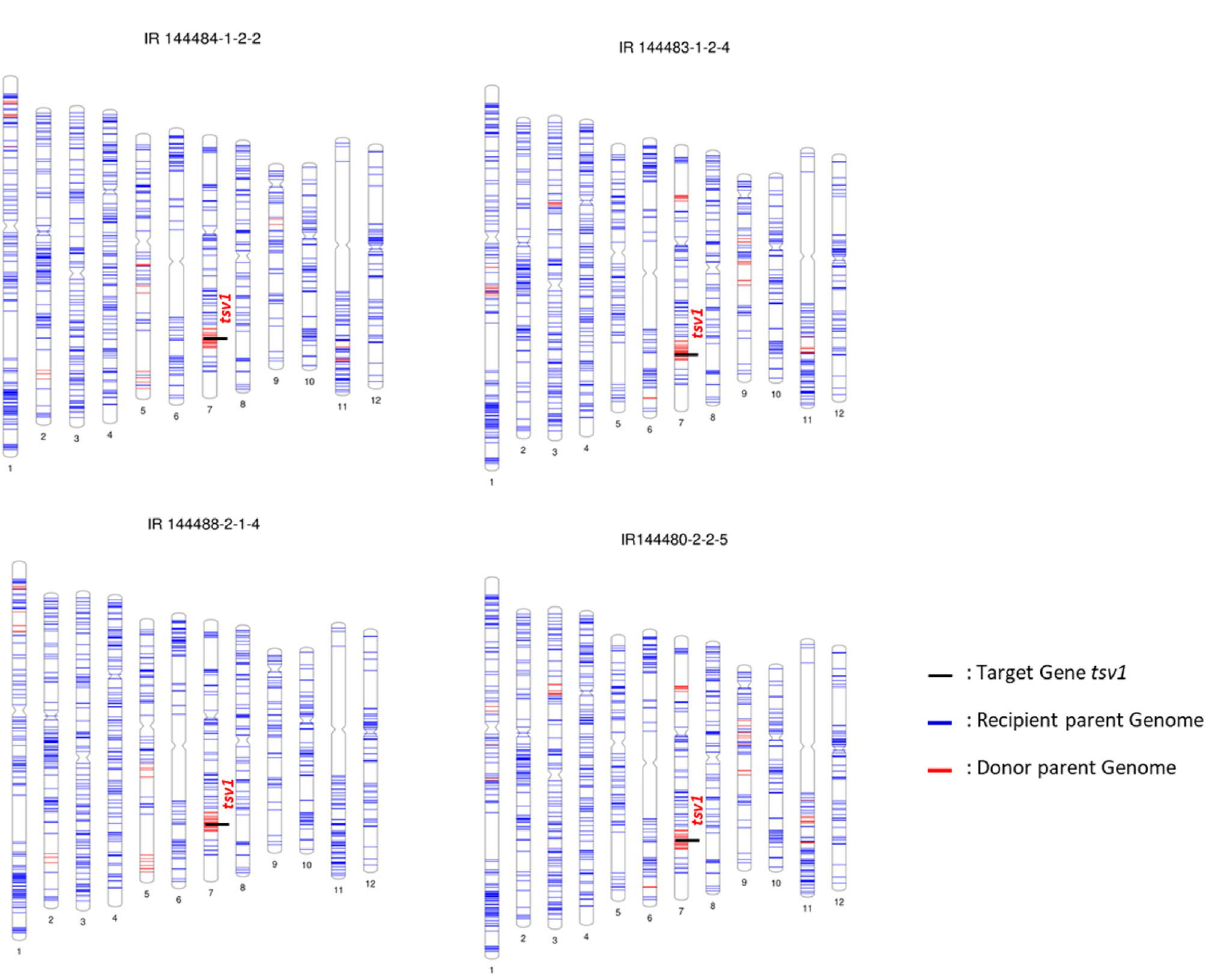
Figure 5. RPG recovery estimation of selected